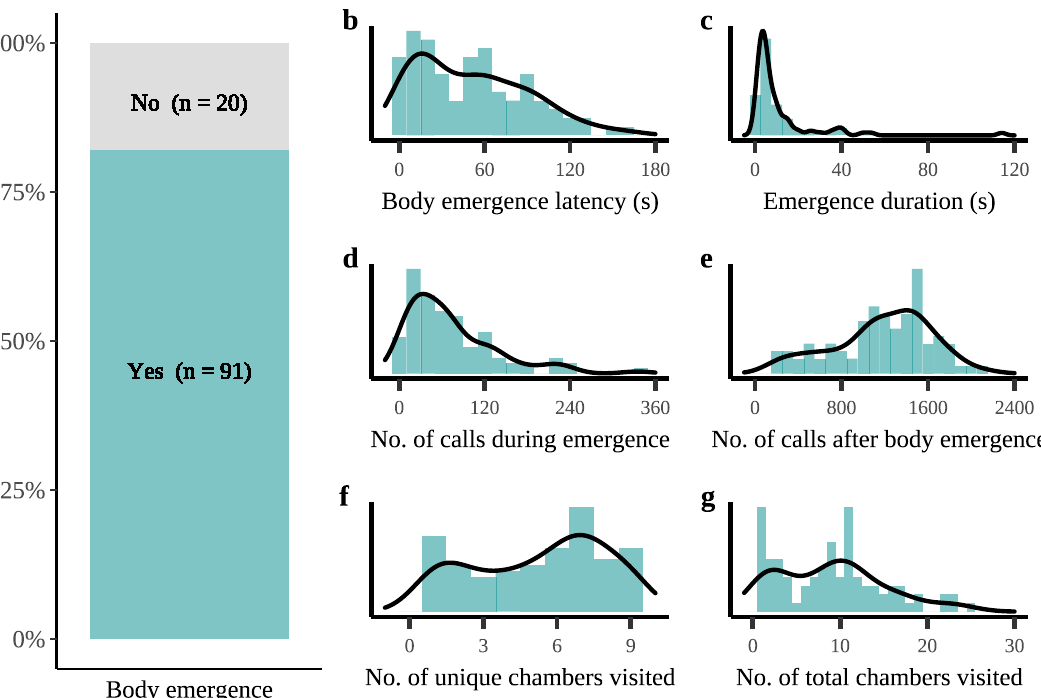
Figure 1. Variance in behavioral responses in Nathusisus’ pipistrelles exploring a novel environment. ( a ) In 82% of the tests, the bat fully emerged out of the starting tube and entered the novel environment (a maze-like arena). The substantial variation in the behavioral response to the novel environment is visualized for ( b ) latency to enter the novel environment (s), ( c ) duration between head and full-body emergence (s), ( d ) the number of echolocation calls during emergence (i.e., time between head and body emergence), ( e ) number of calls after full body emergence, ( f ) number of unique chambers visited and ( g ) the total number of chambers visited during the first two minutes in the novel environment. The lines in panels b–g show the density distribution while the bars show the frequency distribution. Note that although the density distribution extrapolates to negative values, the study data (as shown by the frequency distribution) only included positive